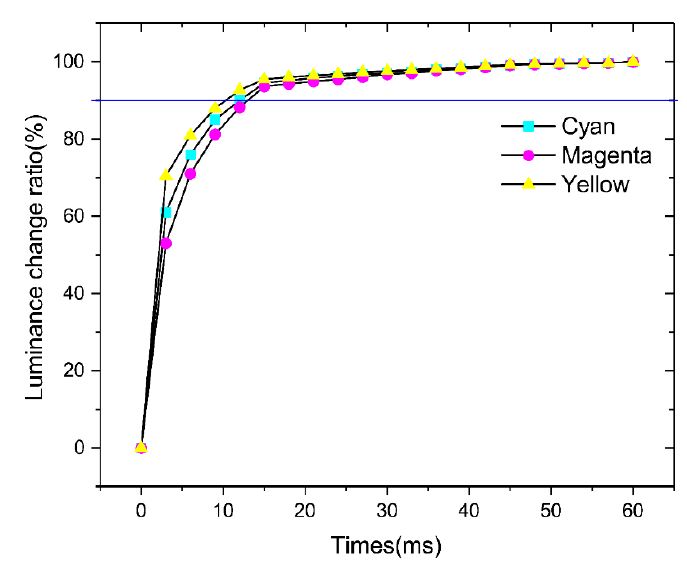
Figure 8. Pixel luminance change ratio due to oil motion as a function of time (switching speed) for each color layer (cyan, magenta, and yellow).